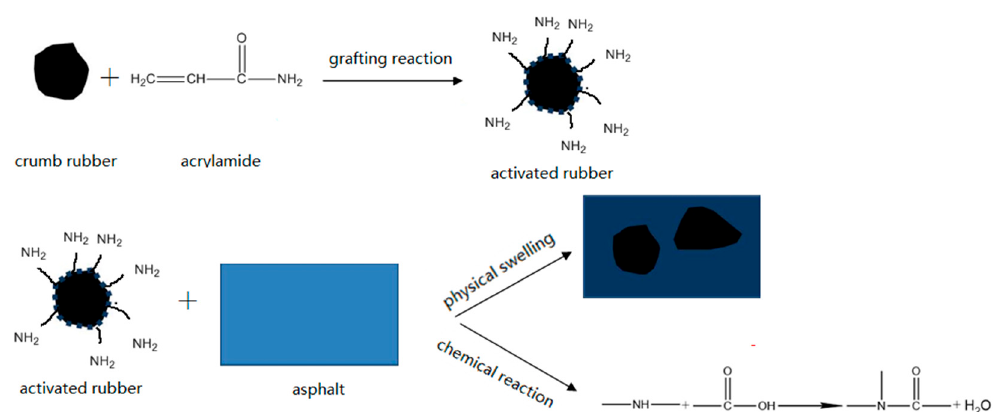
Figure 11. Schematic diagram of the modification mechanism with GR (grafting-activated rubber with acrylamide) .